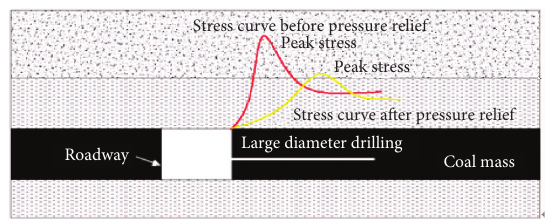
Figure 9: Pressure relief principle of the large-diameter